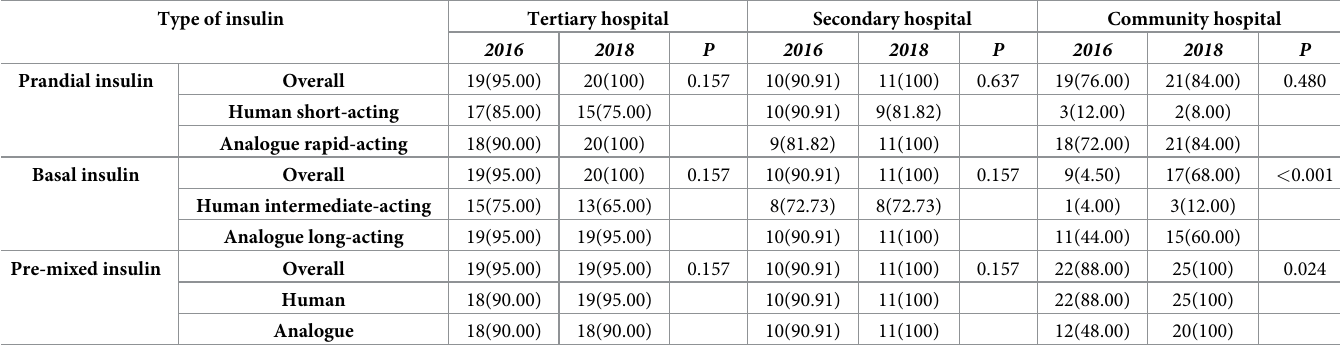
Table 7. Mean availability (%) of insulin products in different-level of pharmacies. Type of